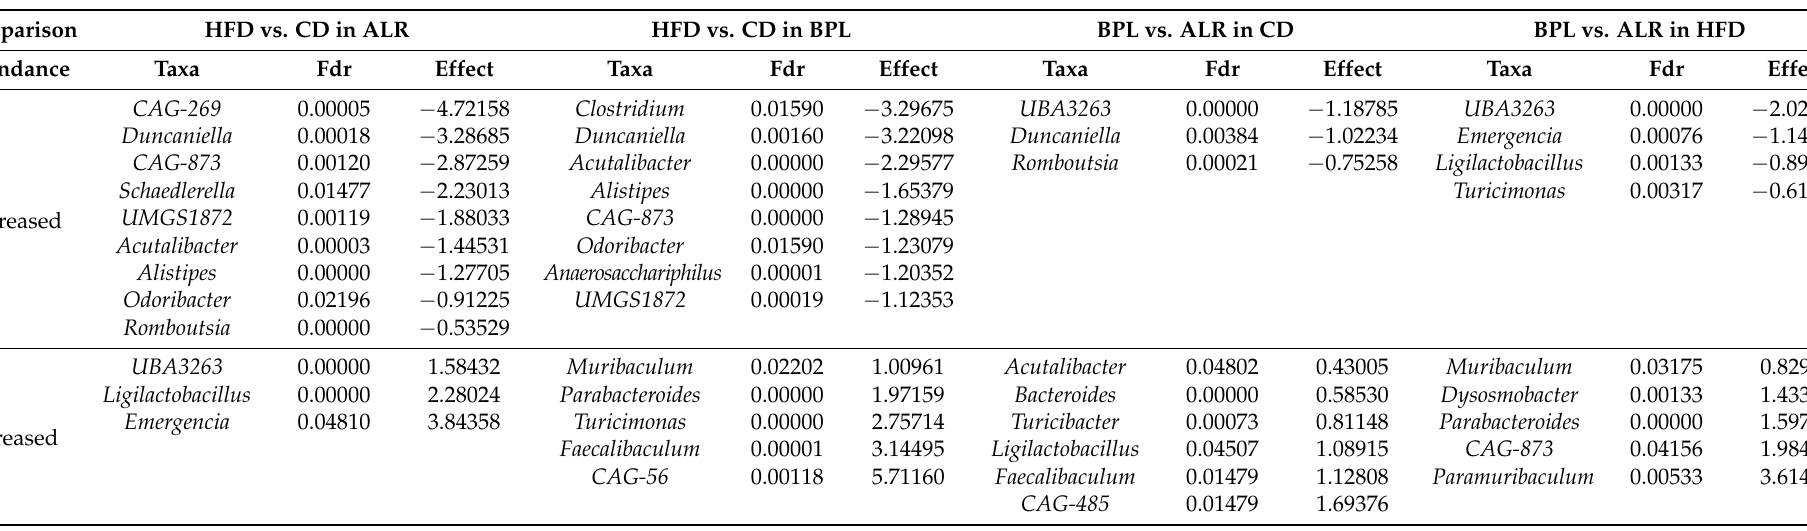
Table 1. The list of differential bacterial taxa at the genus levels in comparison between B6-mt BPL and B6-mt ALR and those with different diet